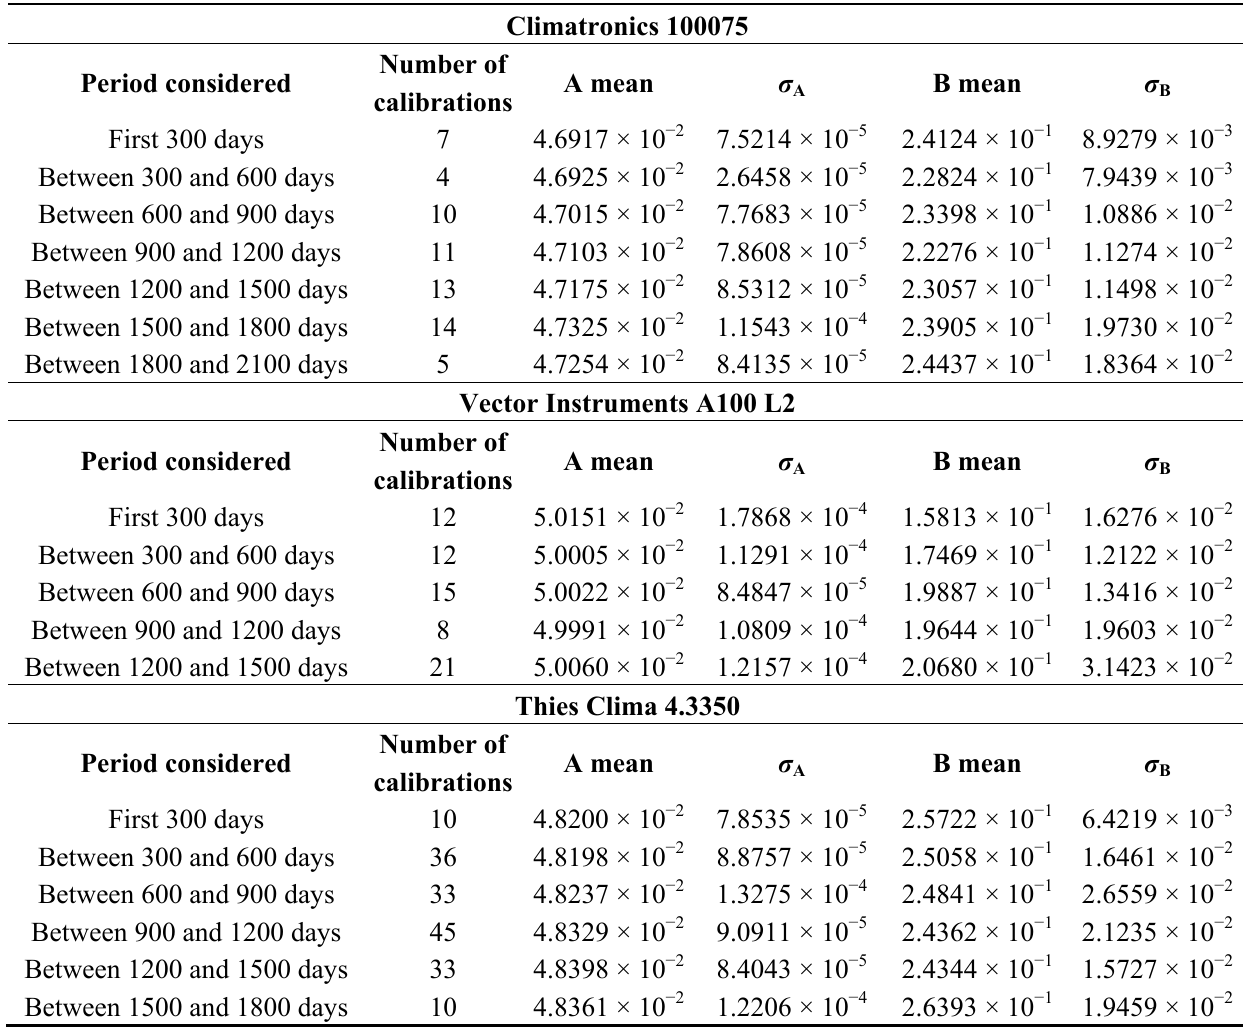
Table 1. Mean and standard deviation values of calibration coefficients A and B every 300 days, corresponding to the IDR/UPM Institute Climatronics 100075, Vector Instruments A100 L2 and Thies Clima 4.3350